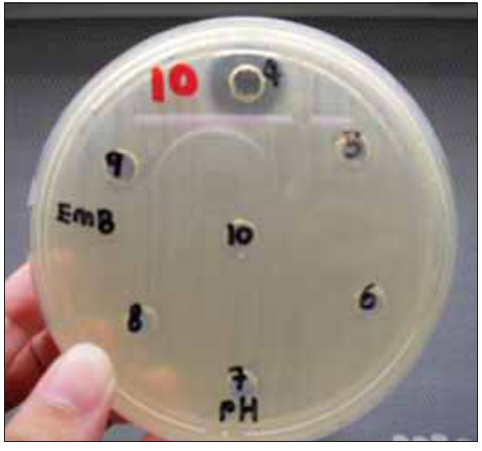
Figure-1: Clear inhibition zone of bacteriocin against Escherichia coli